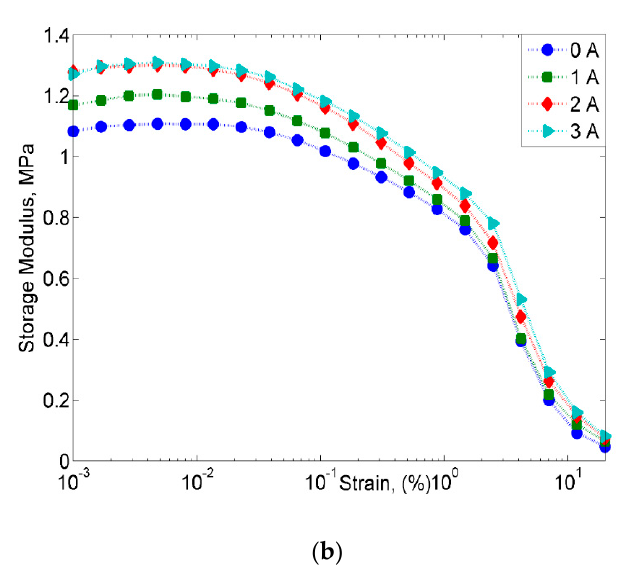
Figure 9. Storage modulus vs. strain for ( a ) MRE with non-corroded CIPs and ( b ) MRE with corroded CIPs.